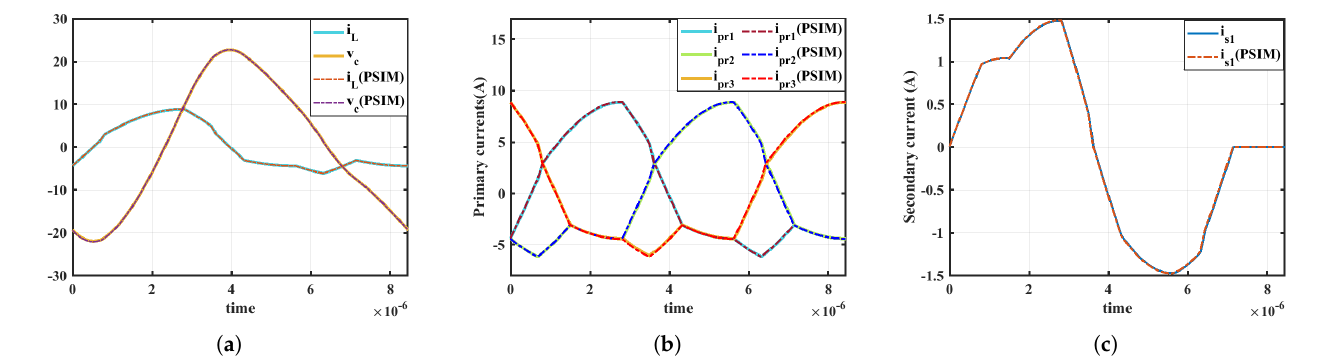
Figure 10. ( a ) Resonant current and voltage across capacitor ( b ) Current in the primary windings i pr 1 , i pr 2 and i pr 3 ( c ) Secondary current i s 1 in DCM1 mode obtained from simulation and